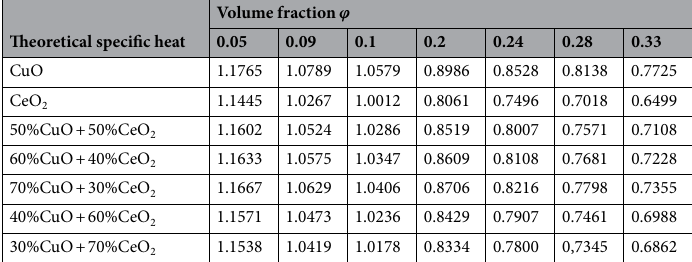
Table 10. Theoretical specific heat of the nanorefrigerant.